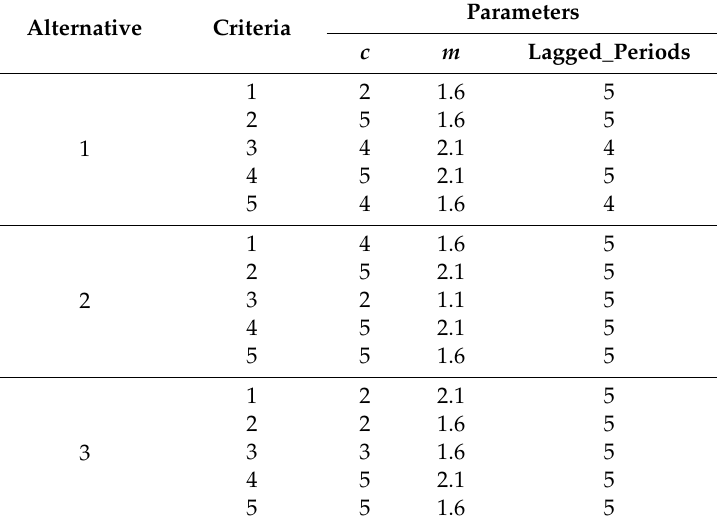
Table 3. Parameters of the